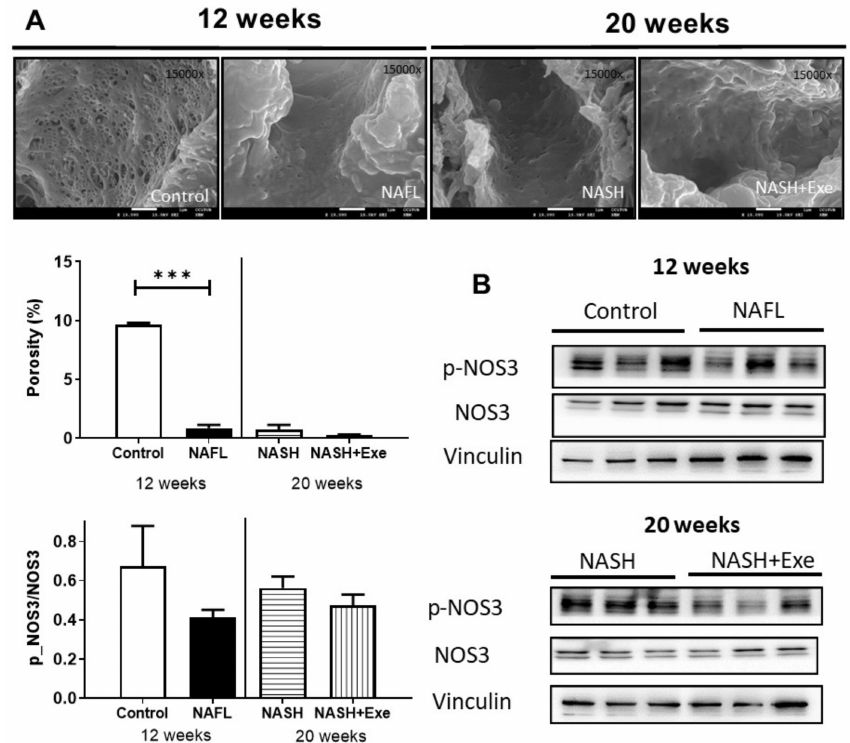
Figure 11. E ff ect of exercise on liver endothelium. ( A ) Scanning electron microscopy images of sinusoids showing endothelial cells from livers of control, 12-week CD-HFD treated (NAFL), 20-week CD-HFD sedentary (NASH), and 20-week CD-HFD exercised mice (magnification × 15,000) (upper panel). Porosity, defined as the percentage of endothelial cell membrane perforated by fenestrations, was quantified (bottom panel) (unpaired t -test; *** p < 0.001). ( B) Immunoblots of the gene product of nitric oxide synthase 3 ( NOS3 ) and its phosphorylated form expressed in liver homogenates of control and NAFL groups (12 weeks treatment), and NASH and NASH + EXE groups (20-week treatment). Immunoblots were quantified and normalized with vinculin. The NAFL, NASH, and NASH + EXE groups are described in Figure 1. For more details of Western blots, please view Figure